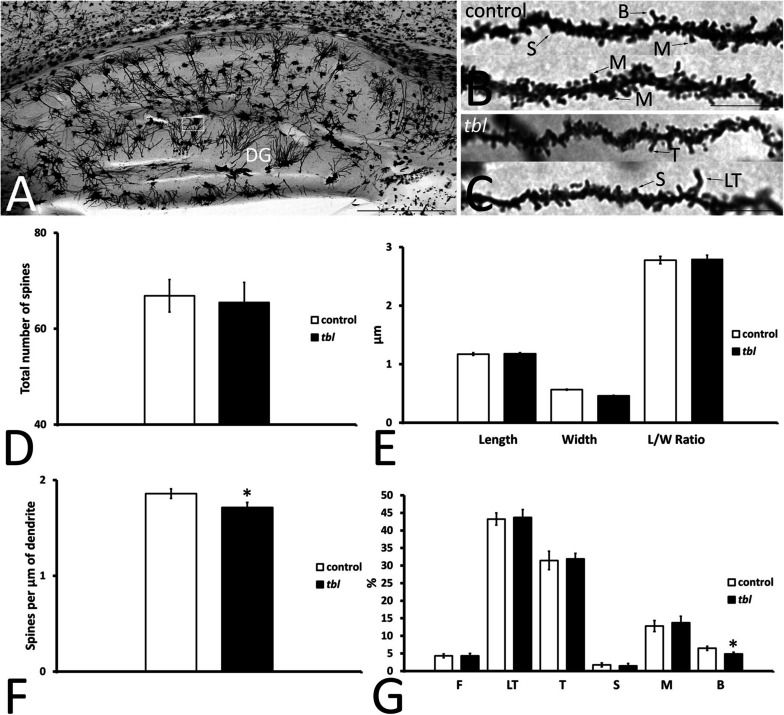
Microphotographs of parasagittal sections through the Golgi-Cox impregnated hippocampus (A). (B–C) Show the completely impregnated dendritic segments of granule cells from the suprapyramidal blade of the dentate gyrus [DG: box in (A) represents the area used to count and categorize the spines]. (D–G) Graphical representation of differences in the number of spines (D), the spine length (E), in spine width (E), the spine length/width ratio (E, L/W ratio), and the density of spines (F) in the DG of control and tbl mice. The proportions of the dendritic spine types counted are shown in (G). No significant differences were found in the number (D; p = 0.7971753), length (E; p = 0.8019998) width (E; p = 0.7770199), and length/width ratio (E; p = 0.8729458) between tbl and control mice. However, the density of dendritic spines was lower in the tbl DG than in the controls (F). The only significant differences in the type of dendritic spines was found in the branched spines, of which there were slightly fewer on tbl granule cell dendrites with respect to the controls (G). The asterisks indicate significant differences in the Student’s t-test: *p = 0.0271162 (F); *p = 0.0418517 (G, B). DG, dentate gyrus; F, filopodia; LT, long thin spines; T, thin spines; M, mushroom spines; S, stubby spines; B, branched spines. Bar = 2 mm (A), and 10 μm (B,C).